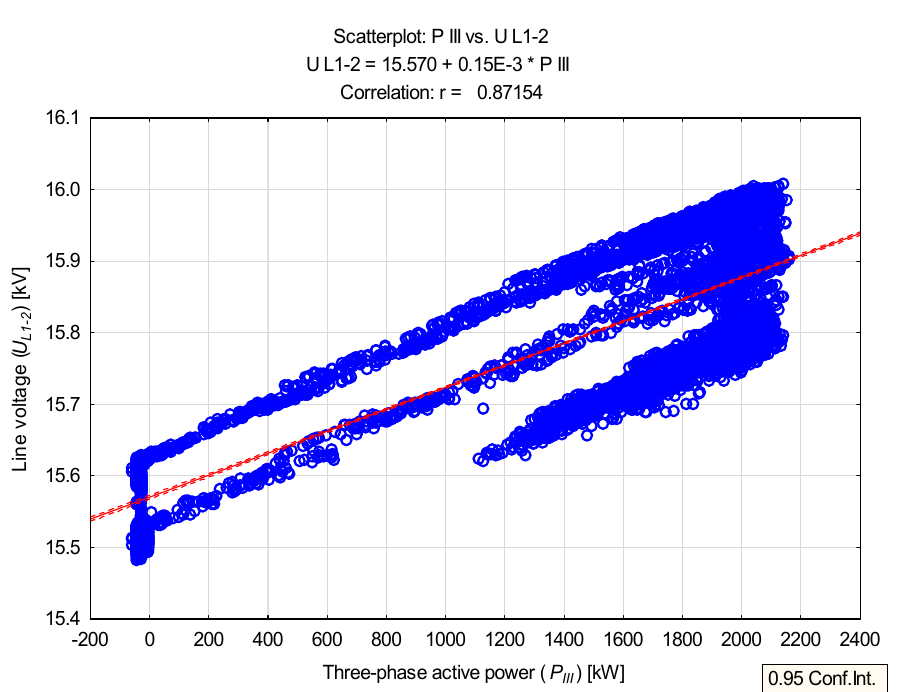
Figure 11. Diagram of the dependence of the value of the line voltage ( U L 1-2 ) at the connection point on the three-phase active power ( P III ) generated by the wind power plant.